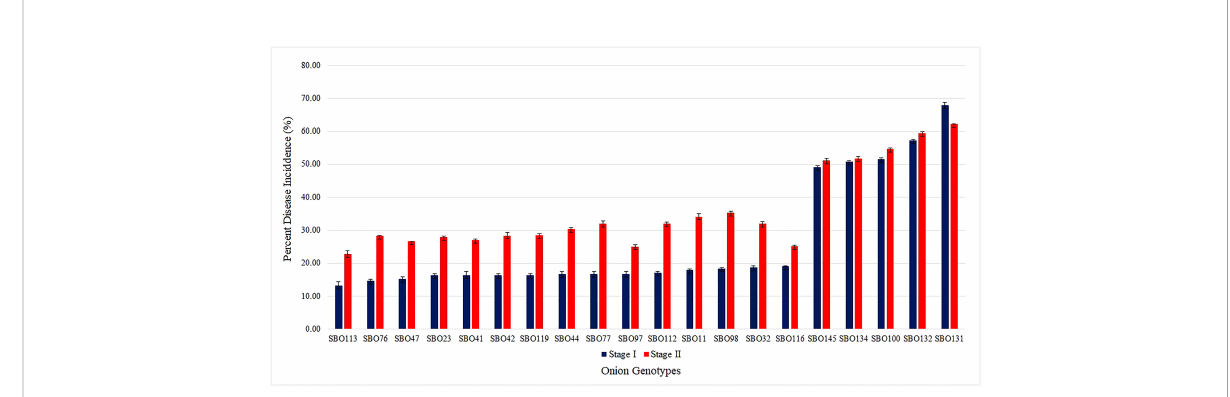
FIGURE 9 Comparison among percent disease incidence (PDI) of selected genotypes under stage I and stage